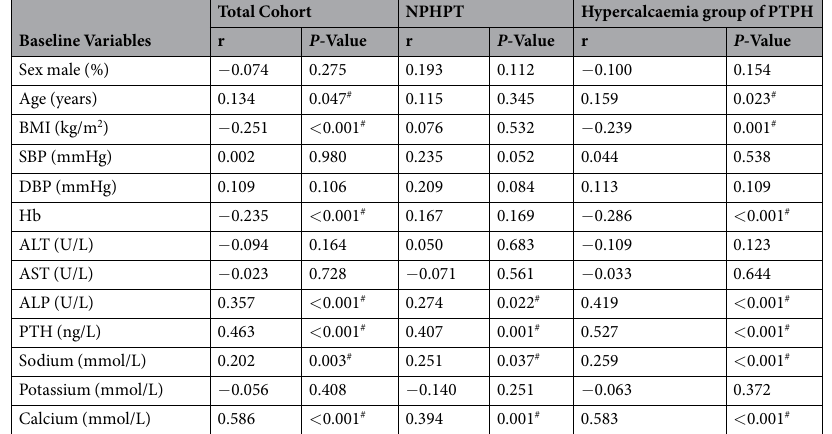
Table 2. Correlations of the chloride/phosphorus ratio (Cl/PO 4 ) with other variables in subjects with PHPT. PHPT, primary hyperparathyroidism; NPHPT, normocalcaemic primary hyperparathyroidism; BMI, body mass index; SBP, systolic blood pressure; DBP, diastolic blood pressure; Hb, haemoglobin; ALT, alanine aminotransferase; AST, aspartate aminotransferase; ALP, alkaline phosphatase; PTH, parathyroid hormone. # P < 0.05 vs . normal controls.